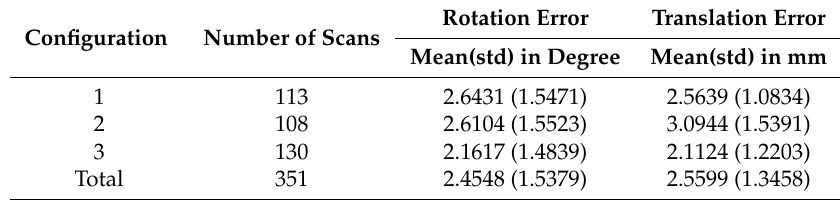
Figure 7. Distributions of the pose difference between the estimated and the reference poses. Table 1. The pose errors in different plane configurations.